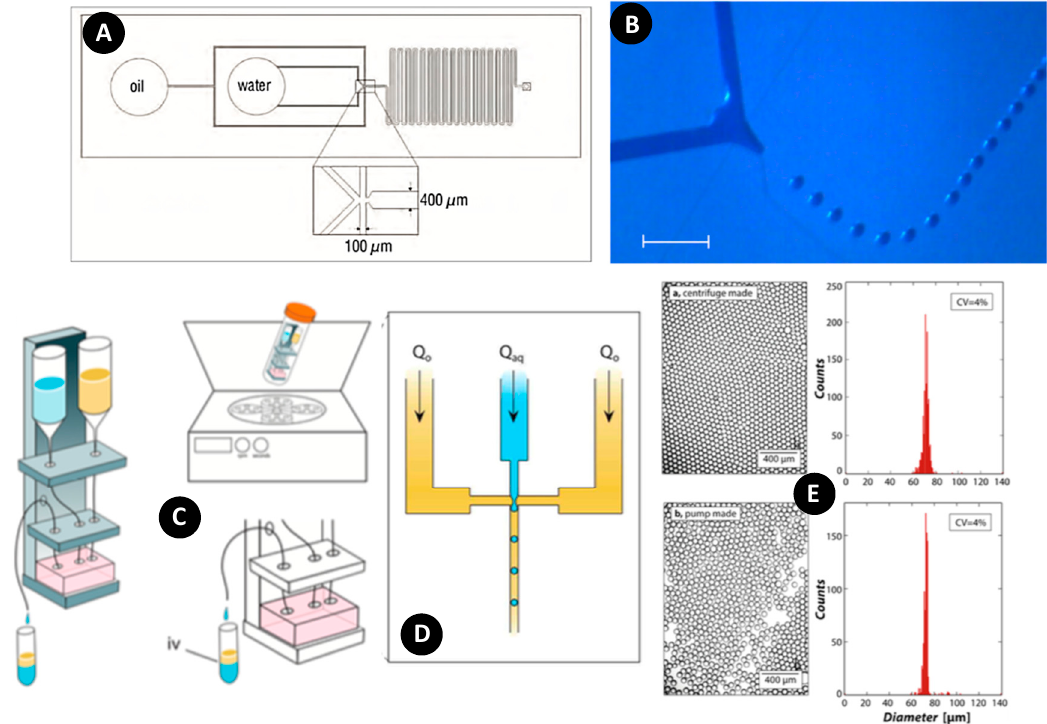
Figure 16. ( A ) Configuration of droplet generation on a centrifugal microfluidic platform; ( B ) Water-in-oil droplet generation at 550 rpm the system. Scale bar 400 µm. Reprinted with permission from [55]; ( C ) Schematic illustration of droplet generation with syringe reservoirs; ( D ) Flow focusing configuration platform for droplet generation; ( E ) A comparison of monodispersity between the results of a syringe pump (lower figure) and centrifugal system (upper figure). Reprinted with permission from [62].